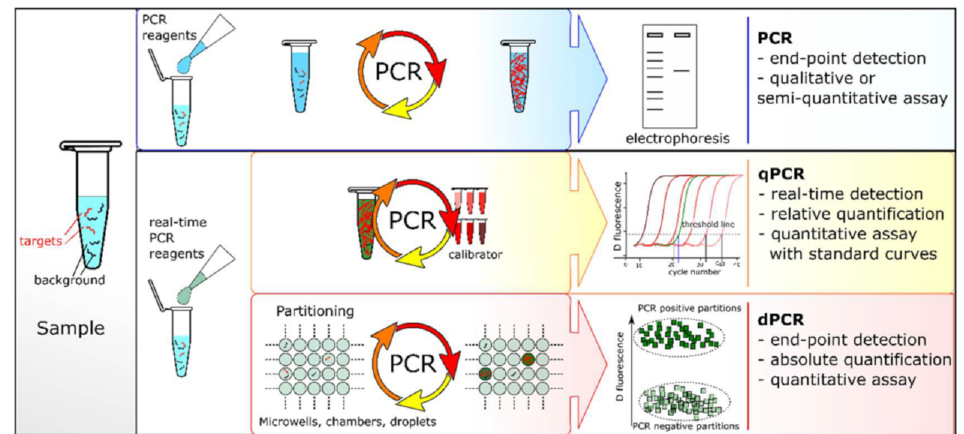
Figure 1. PCR comparisons: end-point PCR, qPCR and dPCR. Reprinted with permission from Ref. [33].Copyright 2018, Quan et